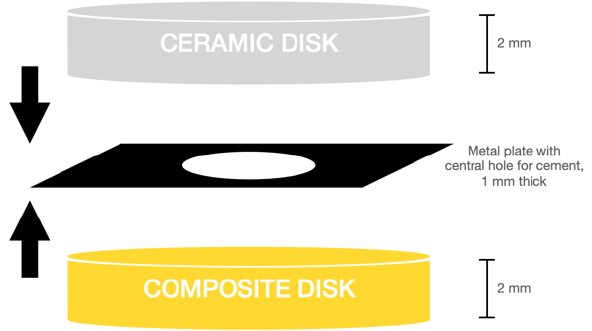
Figure 1. Sample preparation sketch. 2.3. Constant Ratio (CR), Translucency Parameter (TP), and Color Difference Measurements After 24 h storage in distilled water, color coordinates were assessed using a spec- trophotometer (Spectroshade, MHT, Niederhasli, Switzerland) applied on the ceramic side. Measurements were taken using the CIELAB color coordinate system ( L*a*b* ) against black (CIELAB 0,0,0–3% reflectivity) and white (CIELAB 100,0,0–90% reflectivity) backgrounds (Kodak Gray Scale Q-14, Rochester, NY, USA). The spectrophotometer displayed an image on the screen: an operator delimited three separate internal reading areas (3 mm diameter each) near the center of the specimen,